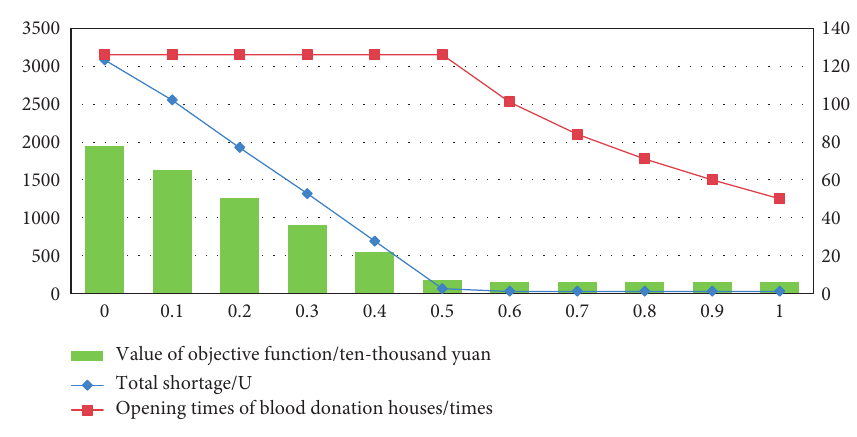
Figure 4: Impact of fluctuations in proportion of apheresis